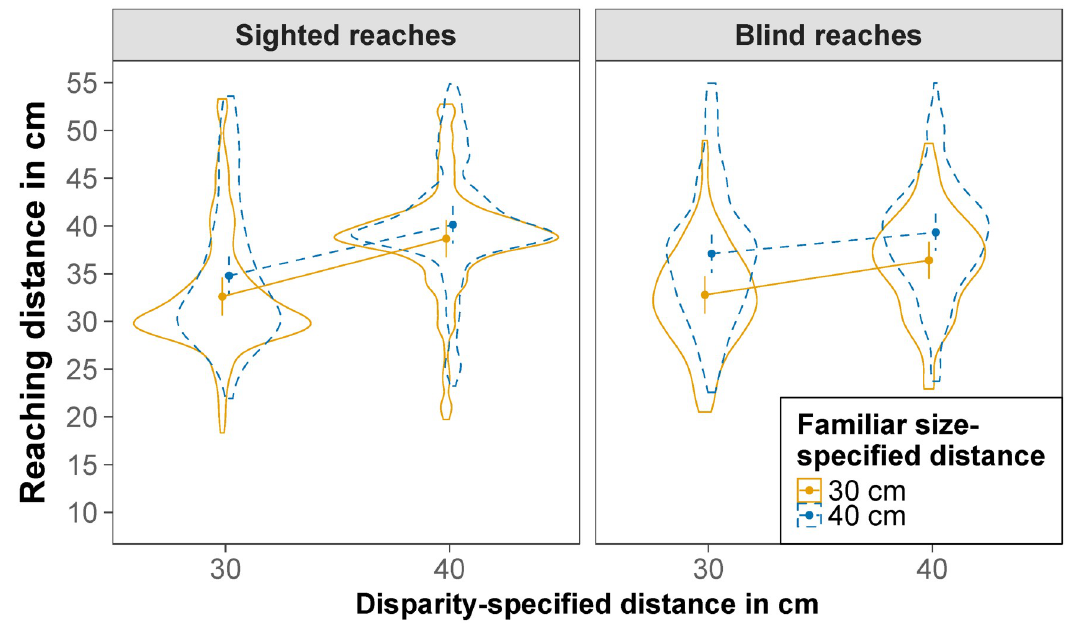
Fig 11. Reaching distance. Estimated marginal means of reaching distance for sighted reaches (left) and blind reaches (right), for a binocular disparity-specified distance of 30 cm and 40 cm and a familiar size-specified distance of 30 cm (solid orange) and 40 cm (dashed blue). Error bars are model-based 95% confidence intervals indicating which values of the estimated means are likely and do not permit comparisons across repeated-measures factors [56]. Violin plots depict the distribution of the raw data.